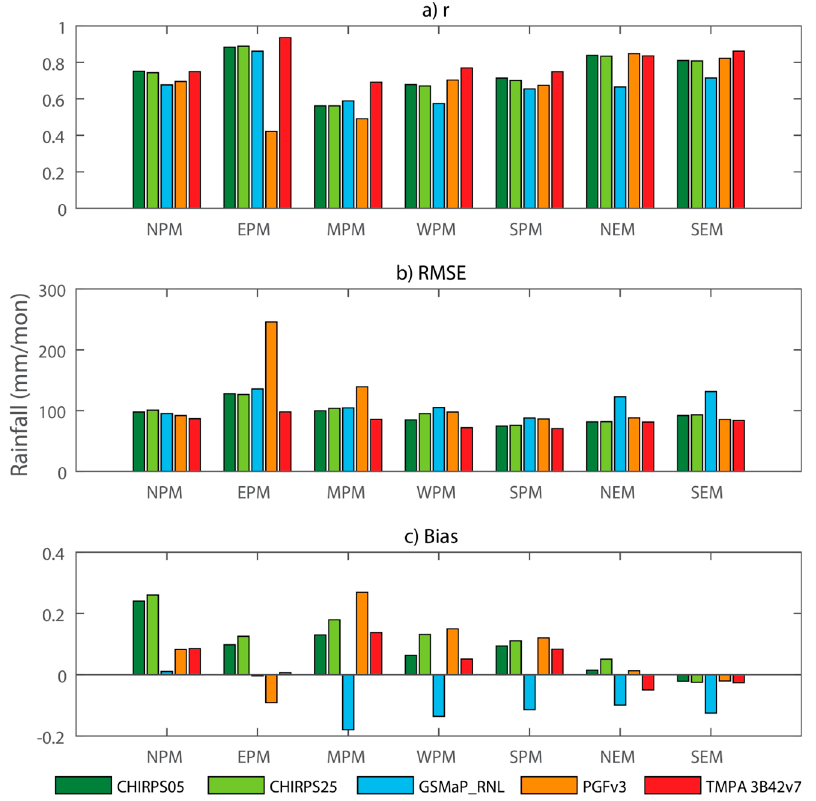
Figure 4. Performance measures of CHIRPS05, CHIRPS25, GSMaP_RNL, PGFv3 and TRMM according to seven sub-regions based on monthly data. ( a ) Correlation, r, ( b ) Root Mean Squared Error, RMSE, ( c ) Bias. Table 6. Categorical performance scores of daily precipitations: POD (Probability of Detection), False Alarm Ratio (FAR), and Critical Success Index (CSI). The best values for each result statistical indicator are in